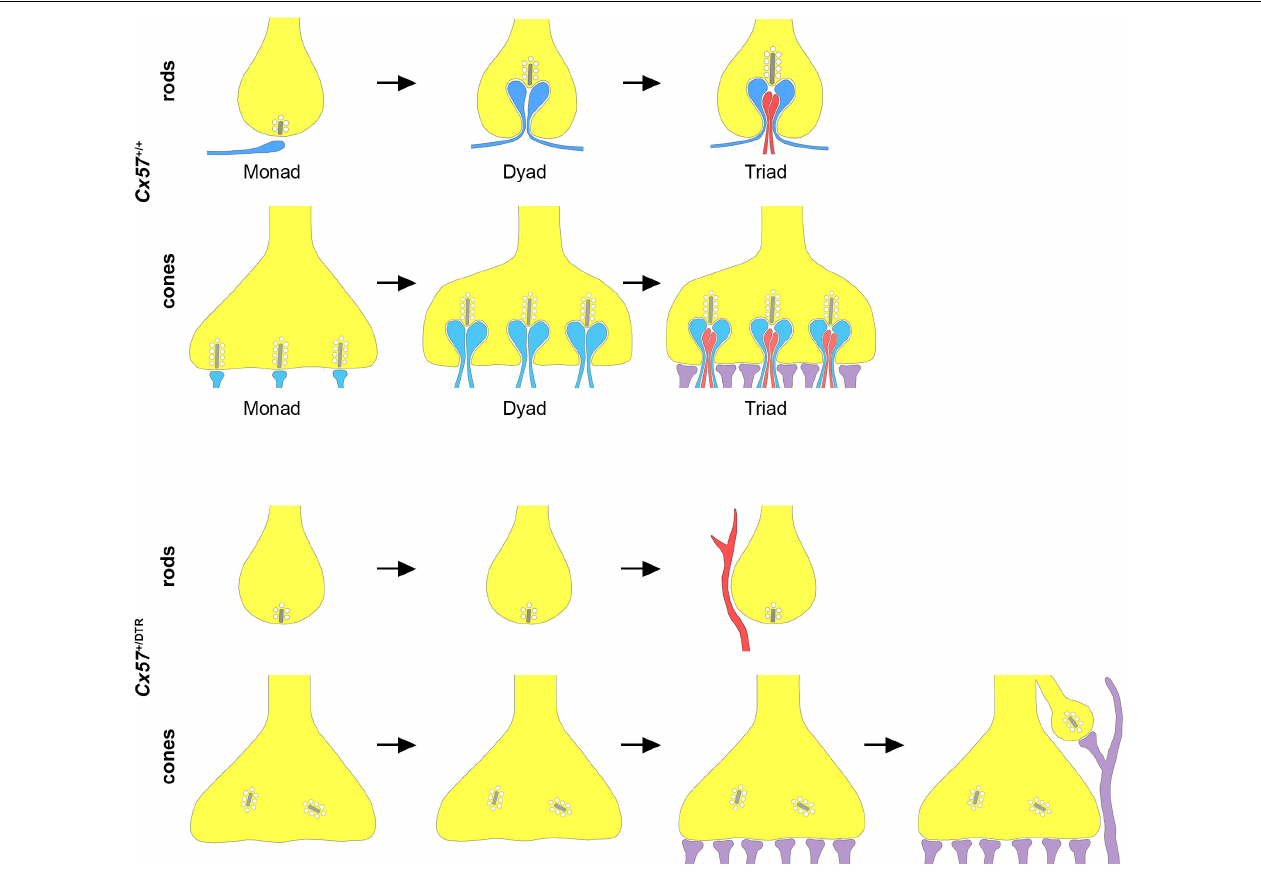
FIGURE 11 | Schematic illustration of rod and cone synaptogenesis in wild-type and horizontal cell-ablated mice. In wild-type mice, the development of rod and cone synapses begins with the formation of a contact between the photoreceptor terminal (yellow) and a single horizontal cell process (blue). Subsequently, a second horizontal cell process is recruited and both horizontal cell processes invaginate into the presynaptic terminal. In the last step, one or two ON bipolar cell dendrites (red) invaginate into the photoreceptor terminal and OFF bipolar cells (violet) form flat contacts at the base of the photoreceptor terminal. In the absence of horizontal cells, ON bipolar cells do not invaginate into rod and cone terminals and rod bipolar cells sprout into the ONL. Compared to wild-type mice, horizontal cell-ablated mice display fewer and shorter presynaptic ribbons, which are often not anchored to the photoreceptor membrane. At later stages, cones form new terminals with synaptic ribbons which are contacted by sprouting OFF bipolar cell dendrites. (Note that synapses between rod terminals and OFF bipolar cells have not been investigated for Cx57 + / + and Cx57 + / DTR mice.)